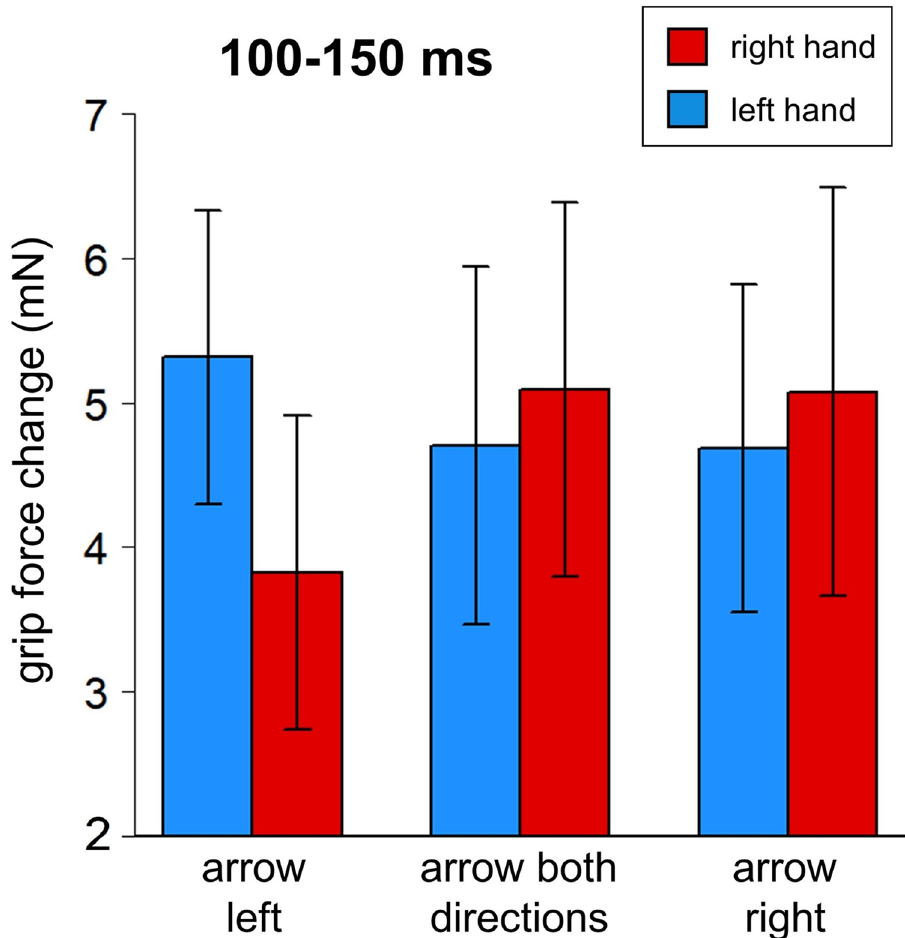
Fig 7. Grip force changes (in milli-Newton) averaged by Hand and Direction in time widow 100–1350 ms, Experiment 2. Whiskers represent standard errors. https://doi.org/10.1371/journal.pone.0262510.g007 pointing arrows (b = -1.279, p = .089). The effect of Hand and the interaction between the two variables were not significant. Marginal r-squared was .006, and conditional r-squared was .508. See Table 8 for further details. 100–150 ms, Models 2.3 and 2.4. The same approach was used as for Experiment 1 (see time windows 60–130 ms and 260–1000 ms). Direction was re-coded as a continuous variable (left: -1; both directions: 0; right: 1). Each force was tested separately, with the contralateral force and Direction as predictors. The effect of Direction was significant in both hands: the left Table 7. Model 2.1. Main effect of Direction (not significant) on grip force in the time window 510–580 ms (Experiment 2). Random